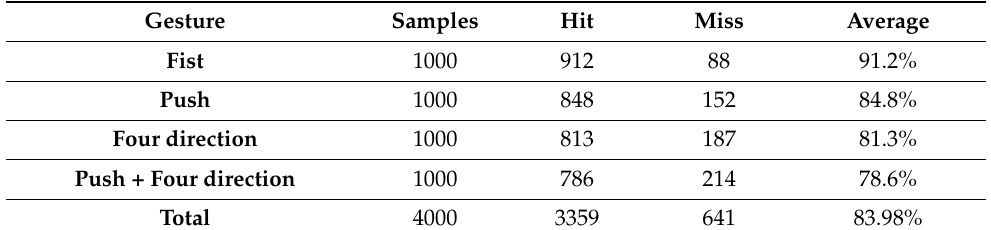
Figure 14. The resource usage of FPGA. Table 3. The recognition rate of the proposed system.